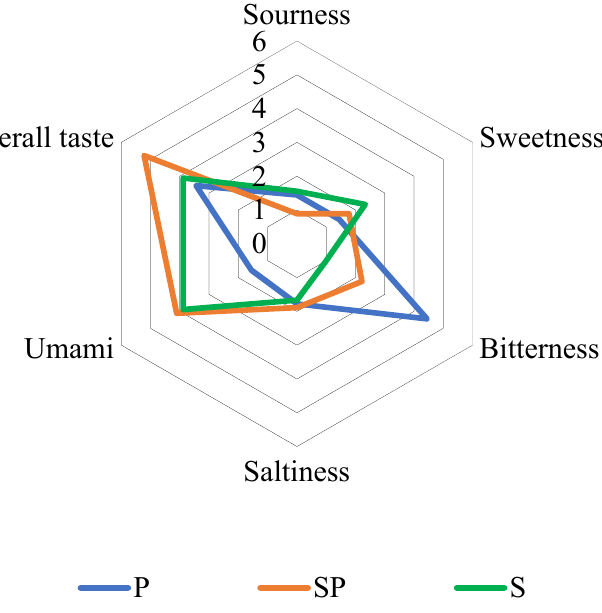
Figure 1. Results of the sensory evaluation.